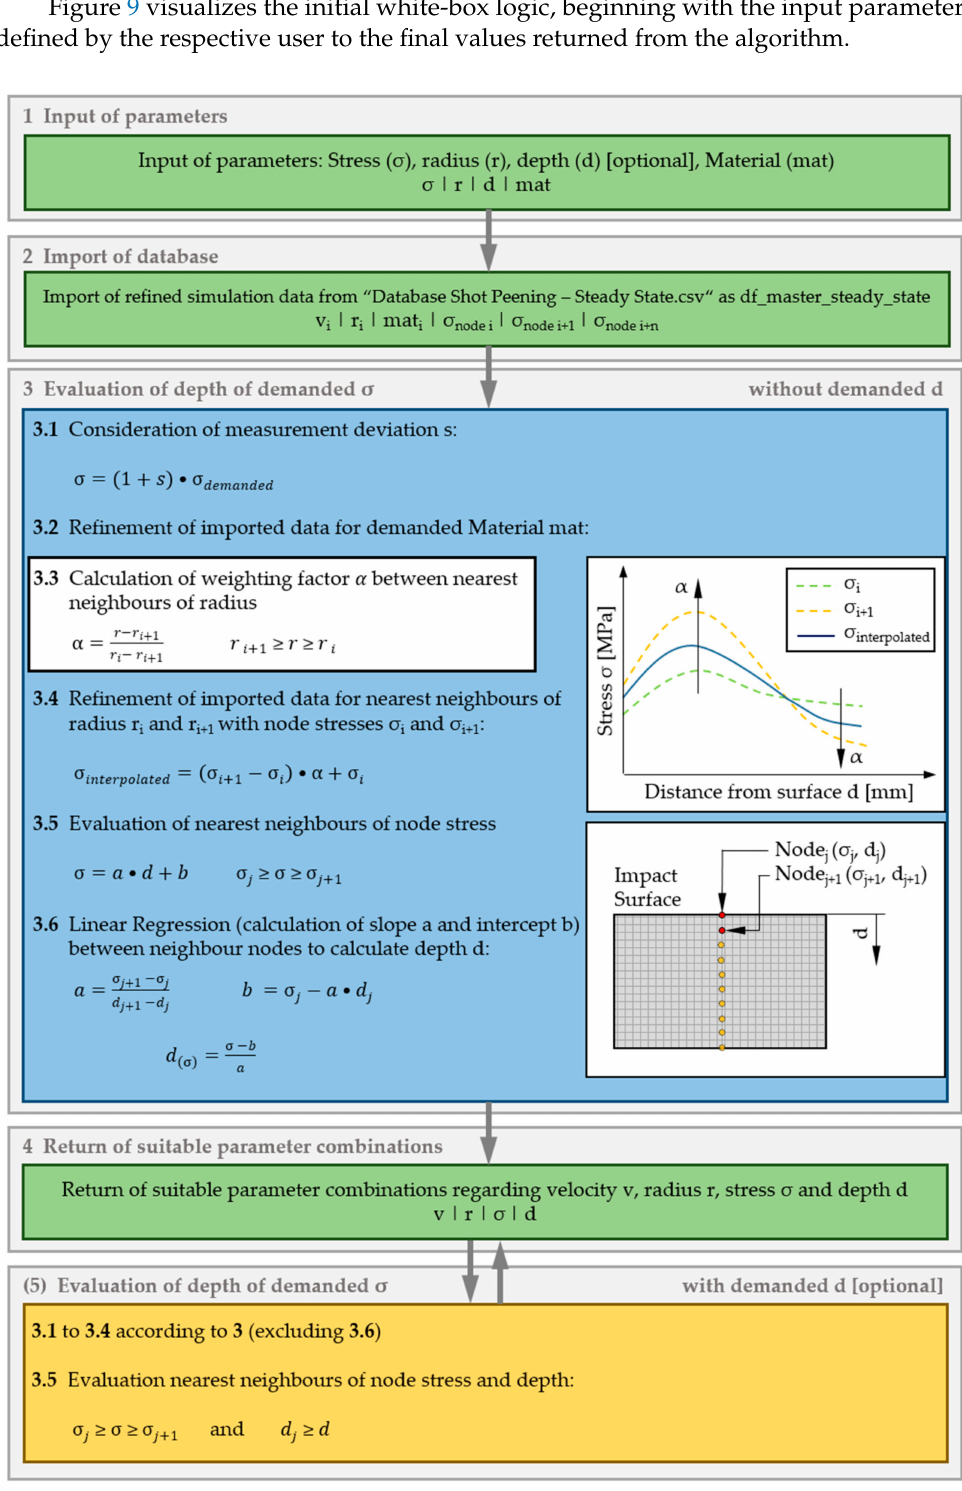
Figure 9. Algorithm for the transformation of user input data (real sphere diameter and desired residual stress, optionally required depth) into shot peening parameters (velocity options suitable for the defined input) by using the master data frame defined in Figure